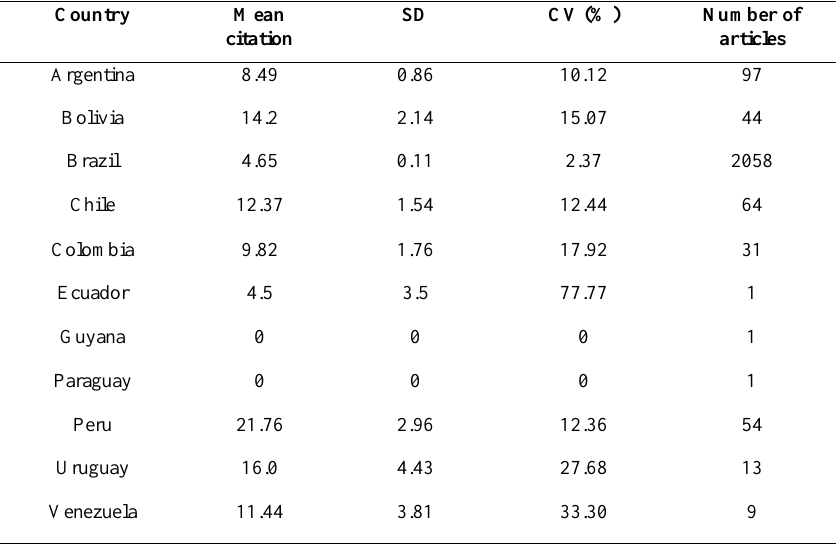
Table 4. Mean ± 1 standard deviation (SD) value of the number of citations per document, coefficient of variation (CV) and number of articles in ISI